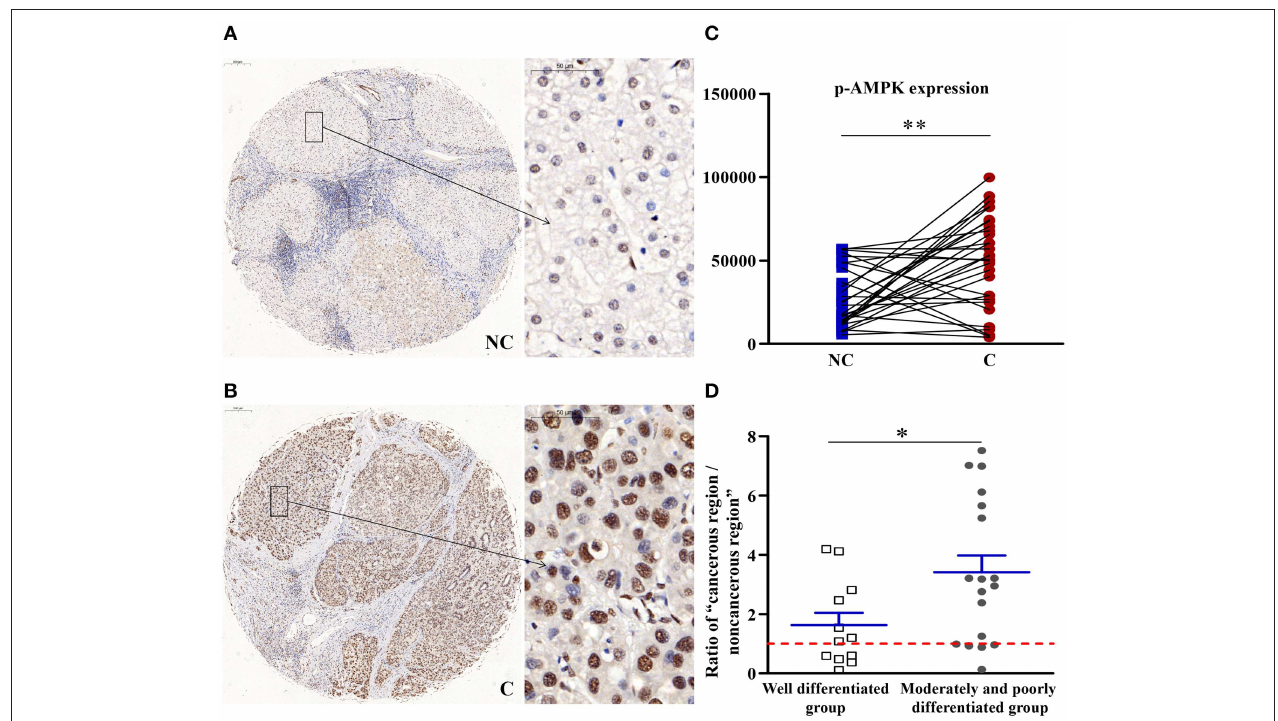
FIGURE 2 | The detailed expression of p-AMPK. Representative images of p-AMPK protein expression in liver cancer’s corresponding (A) non-cancerous (NC) and (B) cancerous (C) regions. (C) Quantification of p-AMPK expression level using multispectral image analysis in the liver cancer samples. (D) The ratio of “cancerous region/non-cancerous region” of p-AMPK expression in two groups (well-differentiated group vs. moderately and poorly differentiated group). The red line indicates that the ratio is equal to 1. Scale bar: 200 or 50 µ m. *Denotes significant differences from the well-differentiated group with P < 0.05; **Denotes significant differences from the noncancerous region with P <